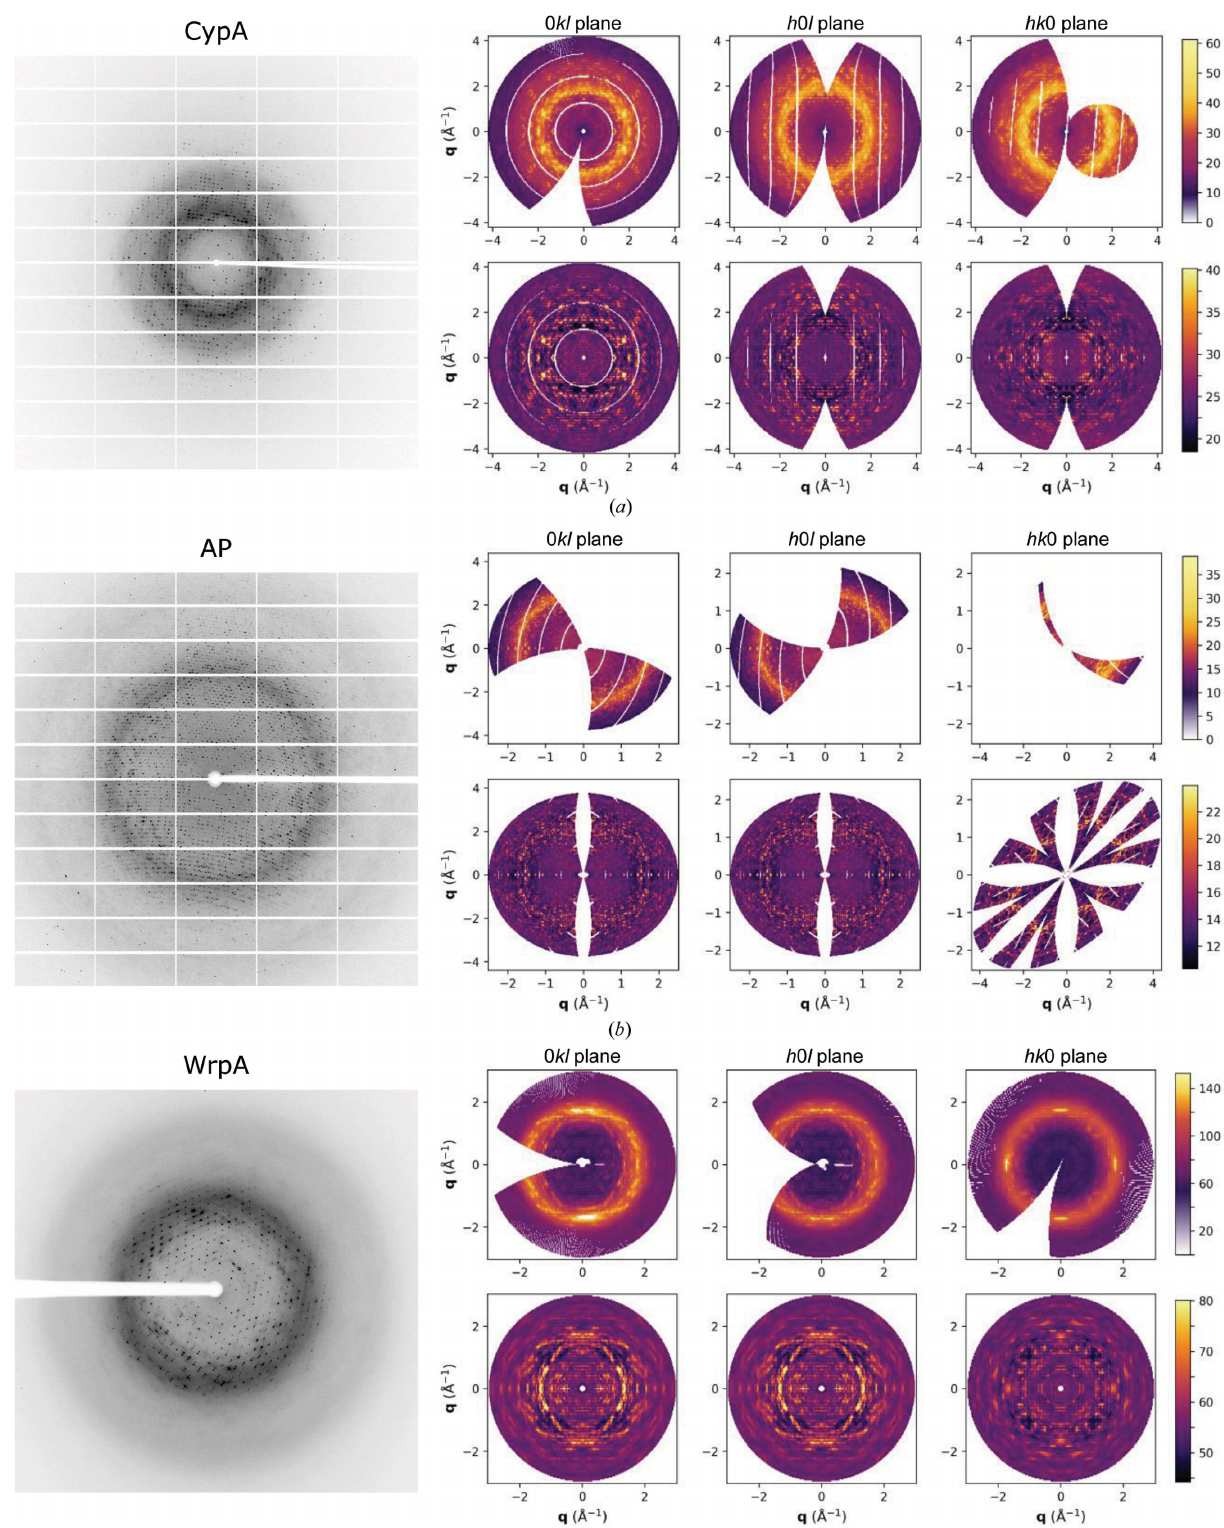
Figure 1 Reciprocal-space maps from experimental diffuse scattering. The diffuse scattering in diffraction images collected for ( a ) CypA, ( b ) AP and ( c ) WrpA was reconstructed into a reciprocal-space map for each system. These maps take the form of three-dimensional grids that are oversampled by a factor of three relative to the Miller indices along each lattice axis. Left: an example diffraction image from each data set. Right: central slices through reciprocal space are visualized for each unsymmetrized map in the top panels. The lower panels show these slices after symmetrization of Friedel- and Laue- equivalent voxels, followed by subtraction of the average radial intensity profile to highlight anisotropic features. For the symmetrized maps, the color scales do not span the entire range of voxel intensities; this saturates a subset of voxels but improves the overall Ariana Peck et al. (cid:3) Diffuse scattering from protein crystals 215